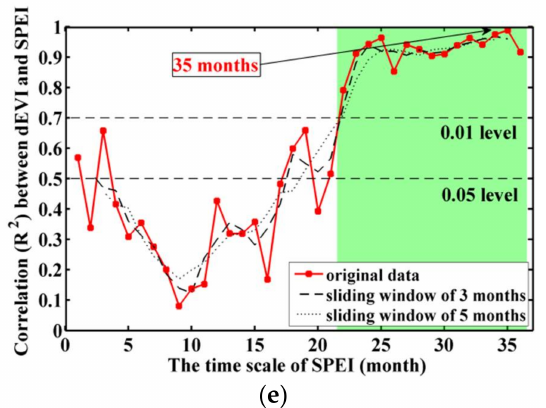
Figure 4. Correlation between dEVI and the SPEI at different time scales for forests with five groups of stock volume density (m 3 · ha − 1 ): ( a ) <30; ( b ) 30–60; ( c ) 60–90; ( d ) 90–120; and ( e ) ≥ 120. The green highlight shows significance at the level of 0.01.